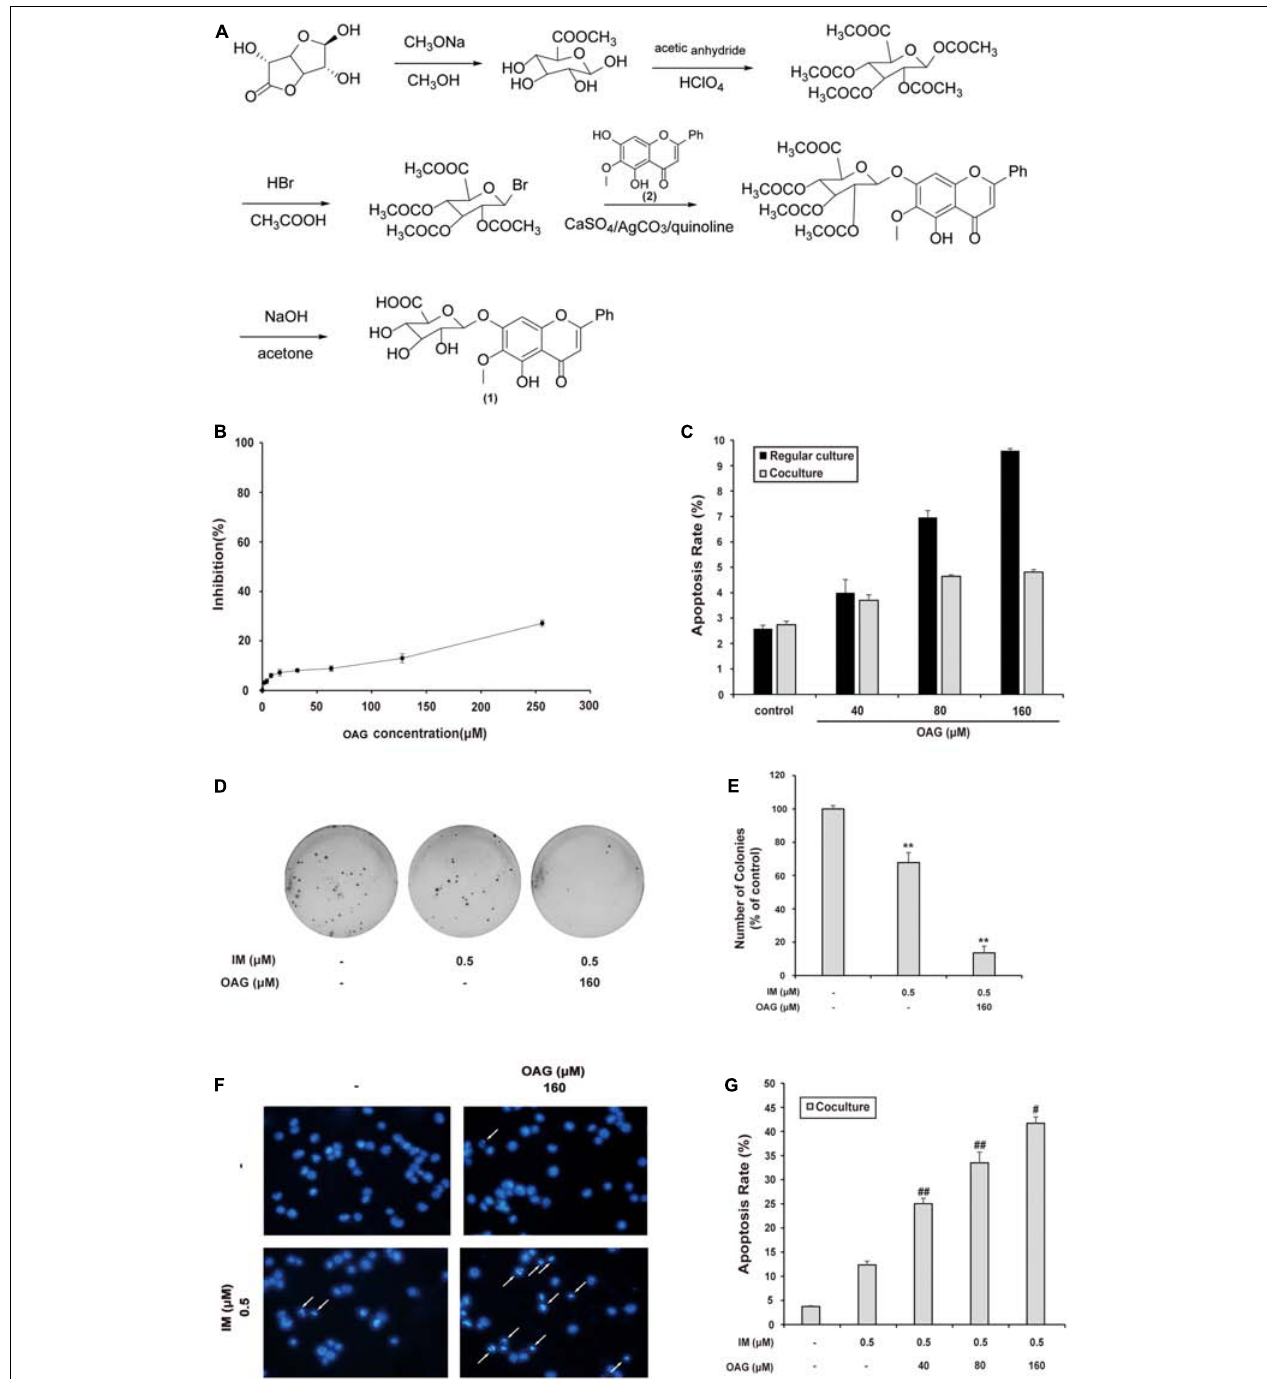
FIGURE 3 | Oroxyloside A (OAG) sensitized CML to IM in co-culture model. (A) The synthetic route of OAG. (1) is the molecular structure of OAG (C 22 H 20 O 11 , MW = 460.39). (2) is OA structure (C 16 H 12 O 5 , MW = 284.26). (B) K562 cells were treated with various concentration of OAG for 36 h, followed by MTT assay. (C) Cells were treated with indicated concentration of OAG for 36 h, and then stained with Annexin V/PI followed by flow cytometry analysis. The apoptotic rates of cells induced by OAG were shown as means ± SD of three independent experiments. (D–G) The co-cultured K562 cells were treated as indicated for 36 h, followed by different assay. Representative photos of soft agar colony assay were shown (D) and the percentage of colonies was represented as mean values of three experiments ± SD (E) . Cell nuclear condensation was pointed out using white arrows in DAPI staining pictures (F) . Toxicity of OAG and/or IM was analyzed by Annexin V/PI double-staining assay using flow cytometry. Data are shown as means ± SD for three independent experiments (G) . ( ∗∗ p < 0.01, ∗ p < 0.05 compared with control and ## p < 0.01, ## p < 0.05 compared with adjacent group)